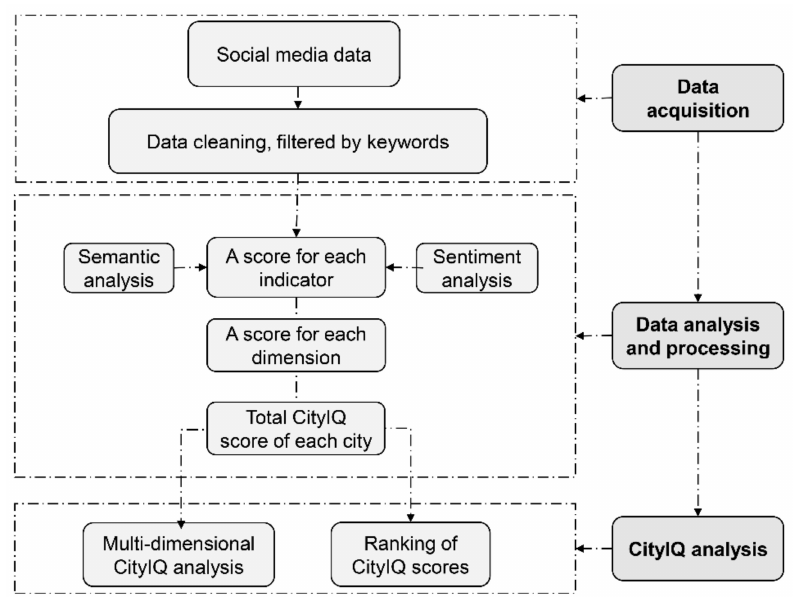
Figure 1. Analytical framework of the CityIQ evaluation